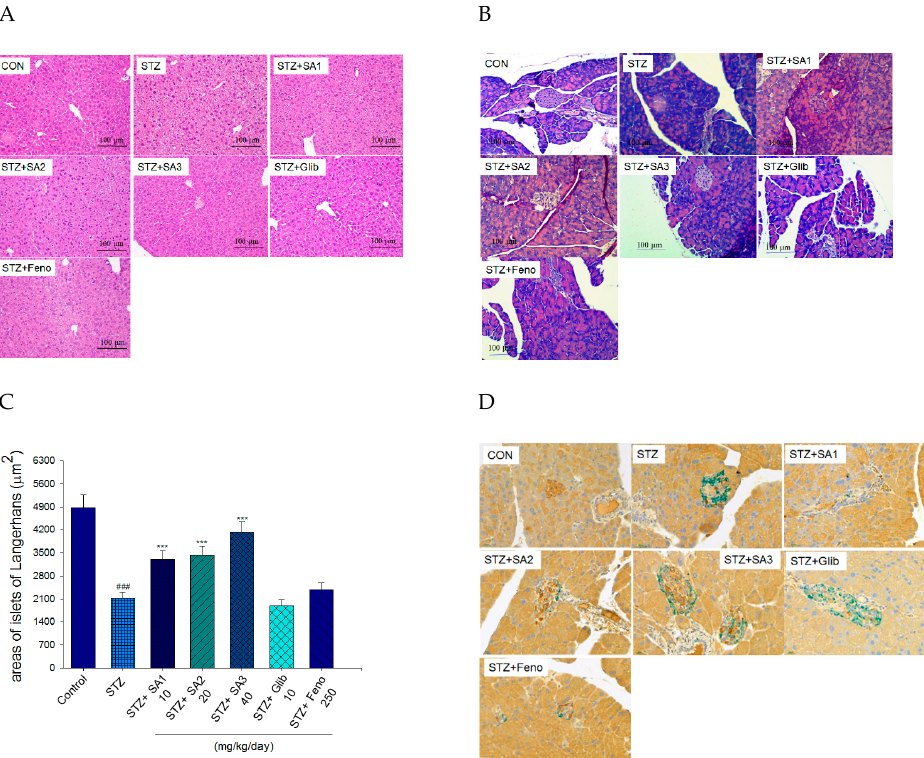
Figure 4. Histology examinations. ( A ) Liver tissues and ( B ) pancreatic islets of Langerhans, ( C ) the average area of islets of Langerhans, ### p < 0.001 compared with the control (CON) group; *** p < 0.001 compared with the streptozotocin plus vehicle (distilled water) (STZ) group. ( D ) scale bar: 400×. an insulin (brown) and glucagon (green) immunohistochemical staining of pancreatic islets of mice in the control (CON), streptozotocin plus vehicle (distilled water) (STZ), STZ + SA1, STZ + SA2, STZ + SA3, STZ + glibenclamide (Glib), or STZ + fenofibrate (Feno) groups ( n = 7 per group) by hematoxylin and eosin-staining. Sulphurenic acid (SA): SA1: 10, SA2: 20, SA3: 40 mg/kg body weight; Glib: glibenclamide (10 mg/kg body weight); Feno: fenofibrate (250 mg/kg body weight).